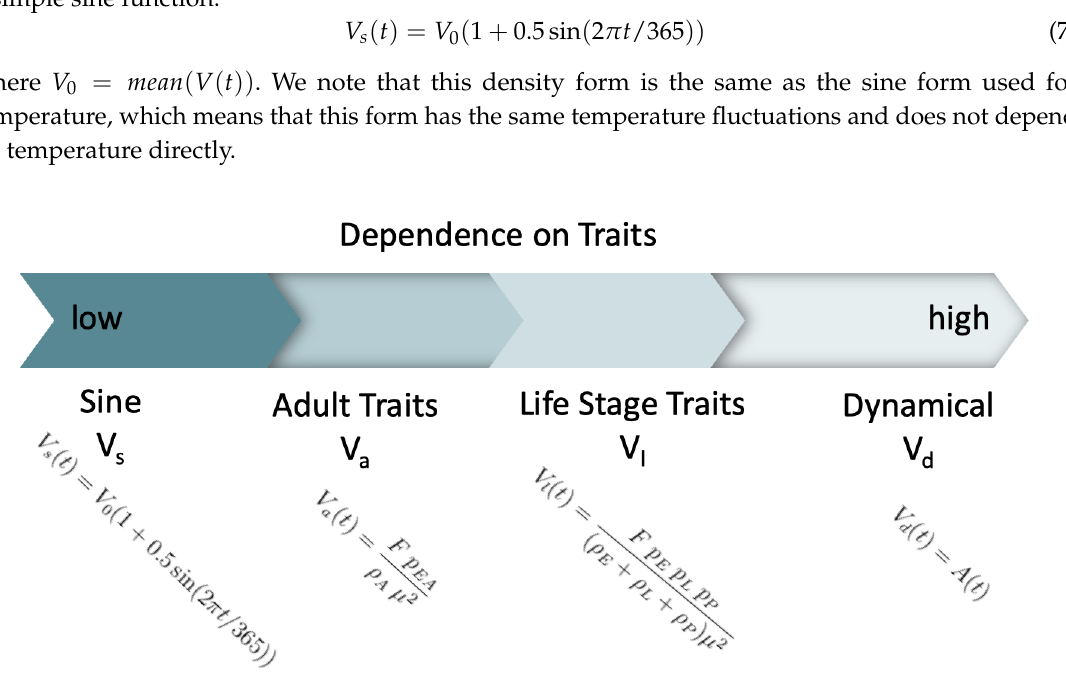
Figure 2. Traits’ dependence spectrum showing the evaluated density forms ranging from low to high traits’ dependence. First, the sine form V s , second the adult traits density V a , third the life stage traits’ density V l , and the dynamical density V d